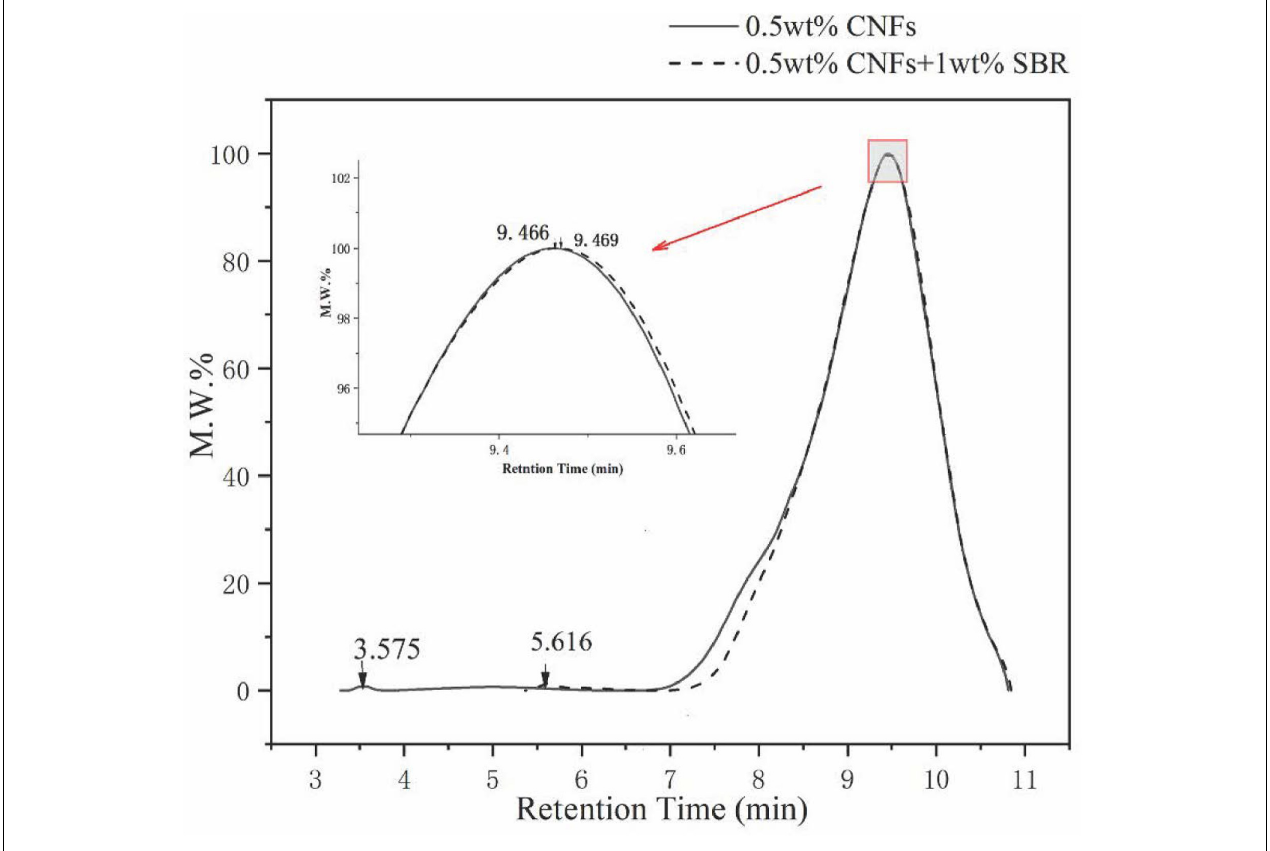
FIGURE 7 | GPC original results of modified emulsified asphalt.